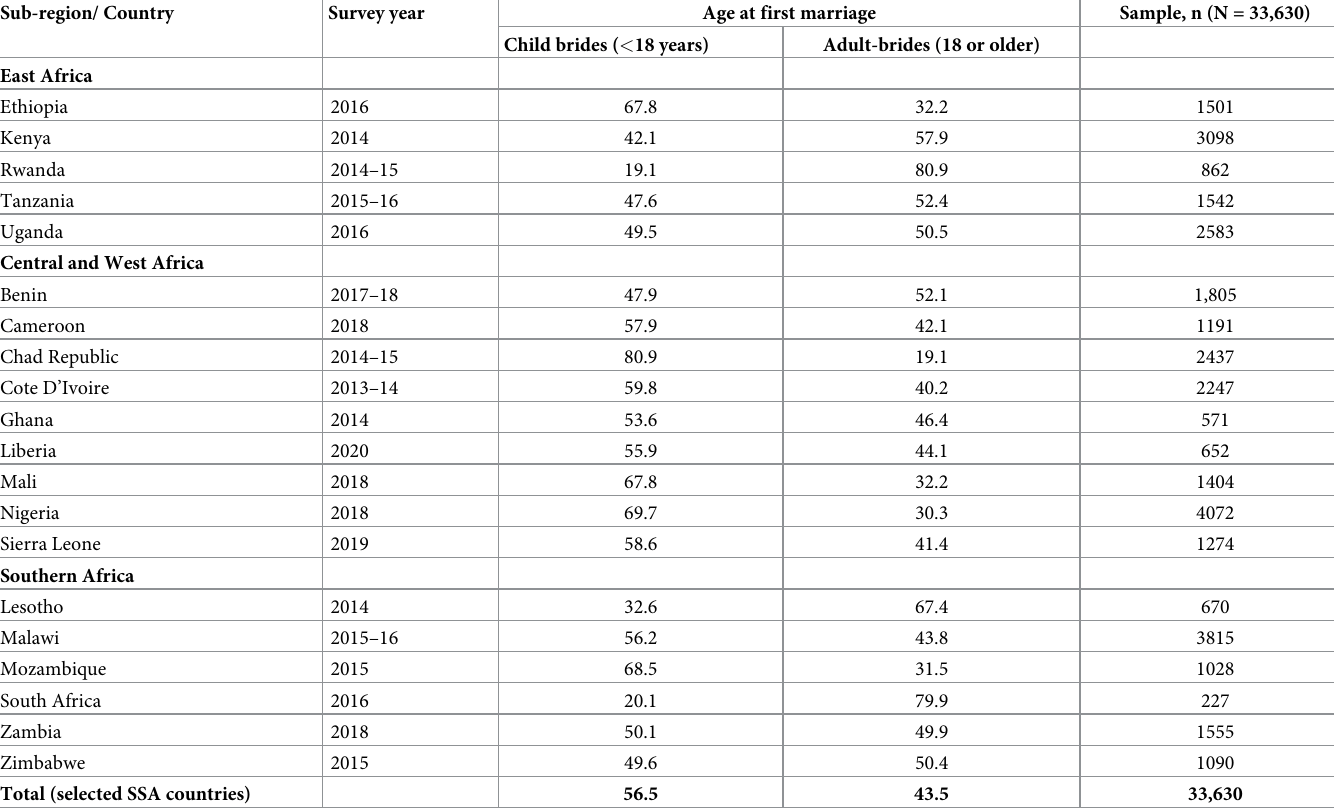
Table 1. Weighted sampled population and percentage distribution of child brides and adultbrides across the selected SSA countries. Sub-region/ Country Survey year Age at first marriage Sample, n (N = 33,630) Child brides ( < 18 years) Adult-brides (18 or